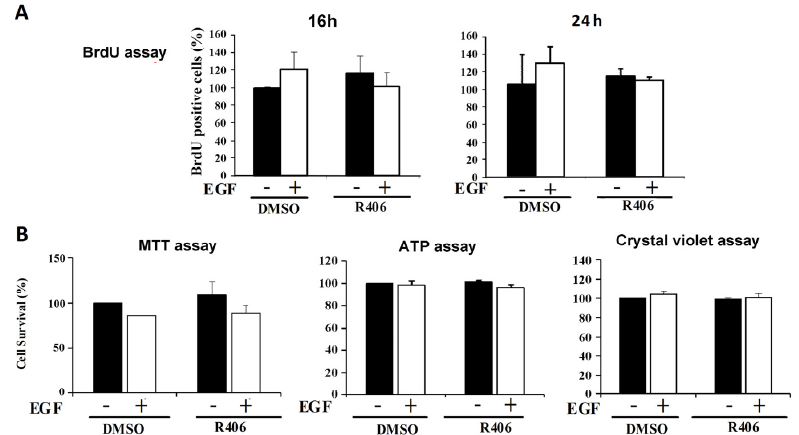
Figure 4. Cont . Figure 4.